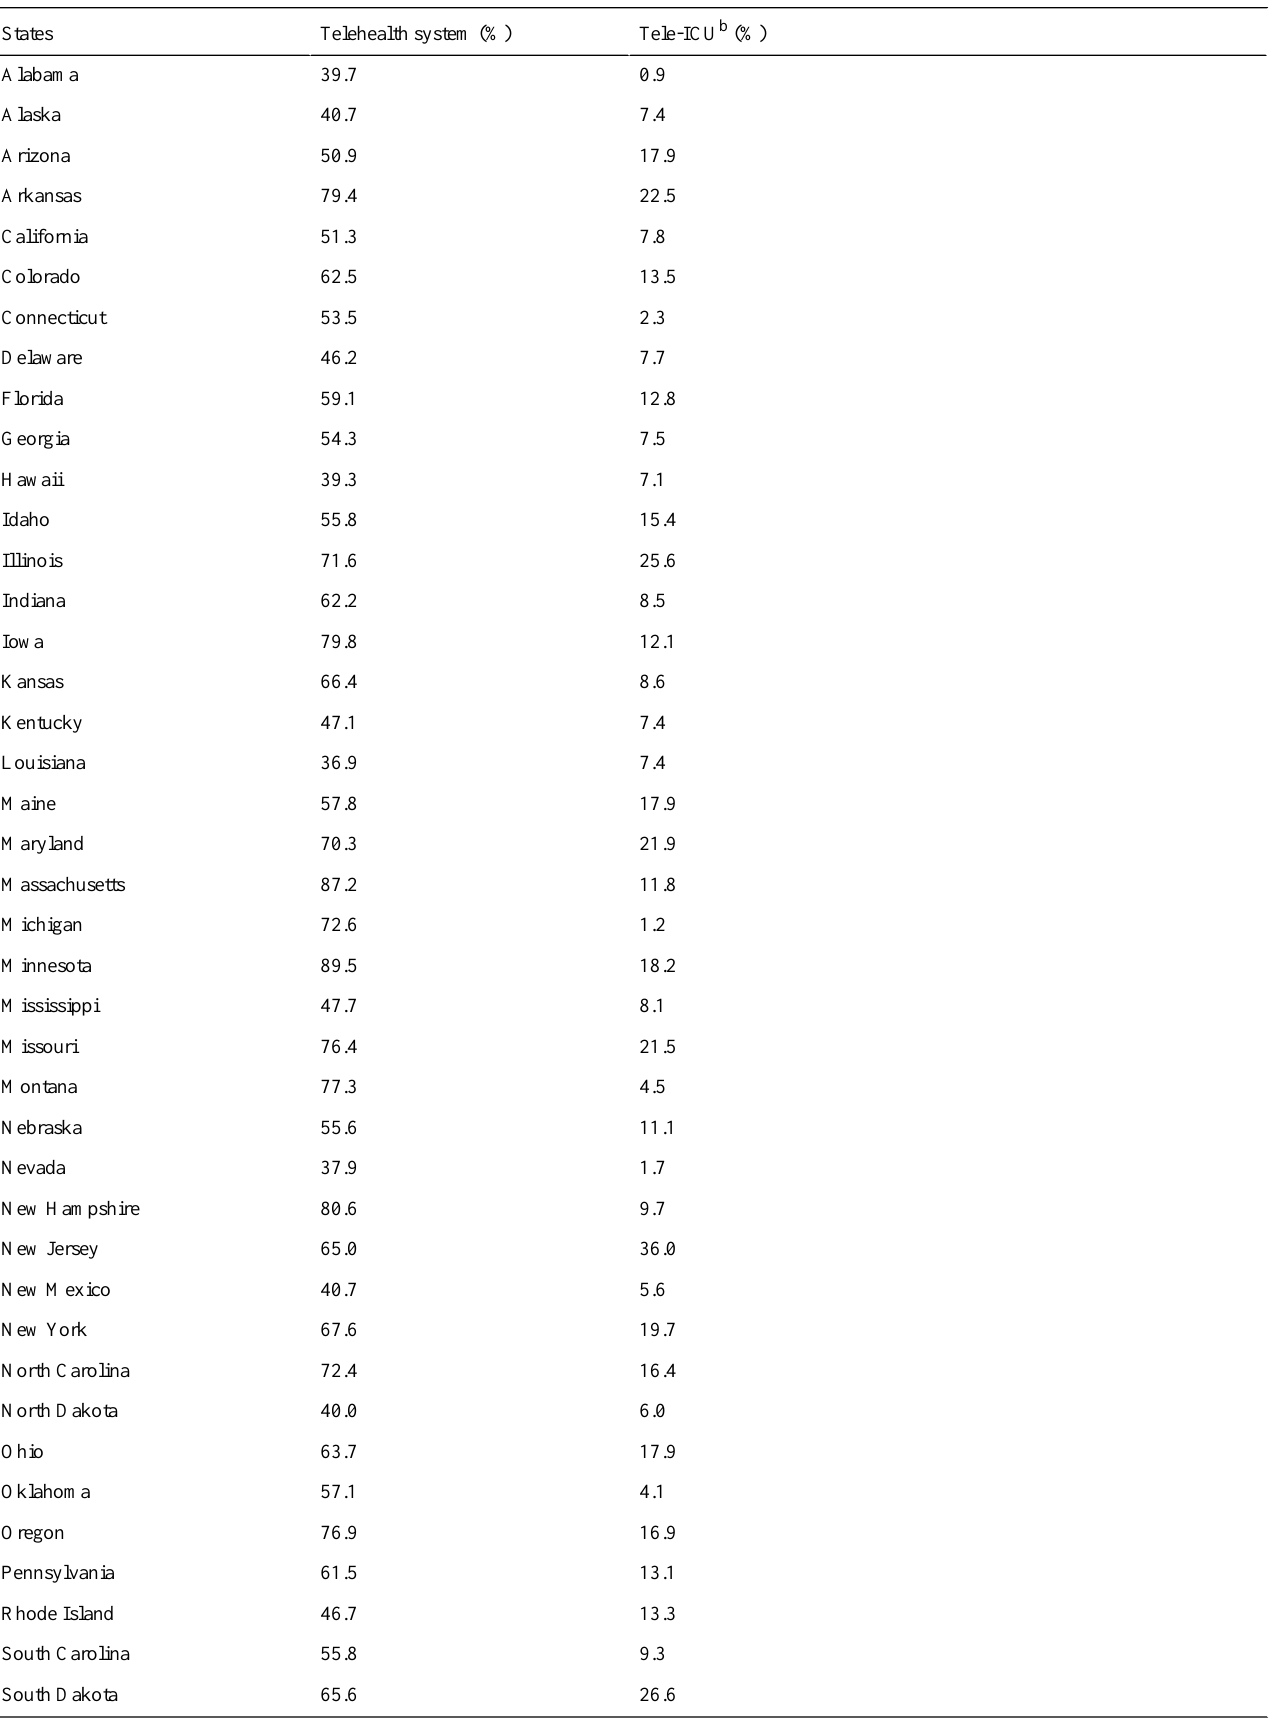
Table 1. Proportion of hospitals having telehealth and telemedicine intensive care unit capabilities in the 50 US states a .